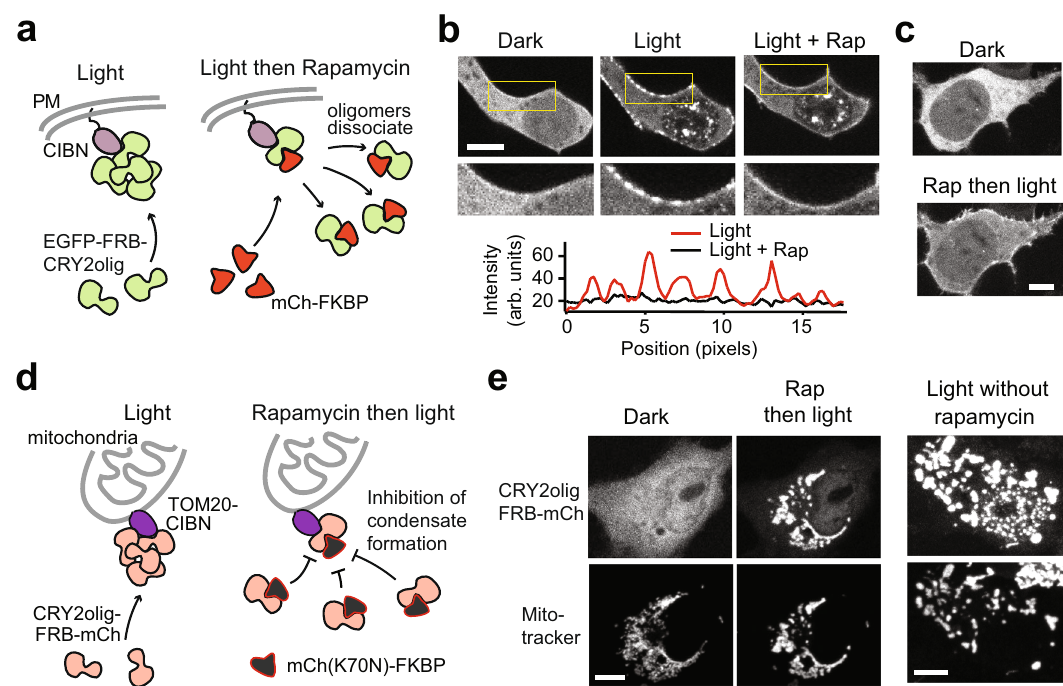
Fig. 5 DisCo blocks CRY2olig self-interaction while maintaining other protein – protein interactions. a Schematic of plasma membrane recruitment experiments, testing effect of DisCo on ability of CRY2 to interact with a plasma membrane anchored CIBN. b HEK293T cells expressing CIBN-CaaX, EGFP- FRB-CRY2olig, and mCh-FKBP as C-BLOCK were illuminated with light (488 nm, 200 ms pulse every 20 s) 18 – 22 h post-transfection. Light-induced CRY2olig condensate formation and recruitment of condensates to the plasma membrane through CIBN interaction. The addition of 333 nM rapamycin (3 min after light onset, ‘ Light + Rap ’ ) disrupted condensates but maintained CRY2olig-CIBN interaction. Magni fi ed images in the second row correspond to the areas outlined in yellow. Graph below shows intensity pro fi le of fl uorescence at the plasma membrane from the magni fi ed areas, indicating the loss of clustering with rapamycin addition. The experiment was repeated a second time with similar results. Scale bar, 10 µ m. c C-BLOCK recruitment prior to light application prevents CRY2olig condensate formation, while allowing CRY2-CIBN association. Experiment was performed as in ( b ), but with rapamycin added 25 min prior to illuminating cells with light (488 nm, 200 ms pulse every 20 s for 8 min). The experiment was repeated a second time with similar results. Scale bar, 10 µ m. d Schematic of mitochondrial recruitment experiments, testing effect of DisCo on interaction of CRY2 with CIBN anchored at the mitochondria. e COS-7 cells coexpressing TOM20-CIBN, CRY2olig-FRB-mCh and mCh(K70N)-FKBP as C-BLOCK were imaged in dark ( ‘ Dark ’ ), then treated with 333 nM rapamycin followed by light (488 nm, 100 ms every 30 s) ( “ Rap then light ” ). CRY2olig treated with rapamycin prior to light does not form condensates but is still recruited to CIBN. At far left are images of cells illuminated with light in the absence of rapamycin, which results in CRY2olig oligomerization at the mitochondrial membrane and mitochondrial compaction. The experiment was repeated a second time with similar results. All scale bars, 10 µ